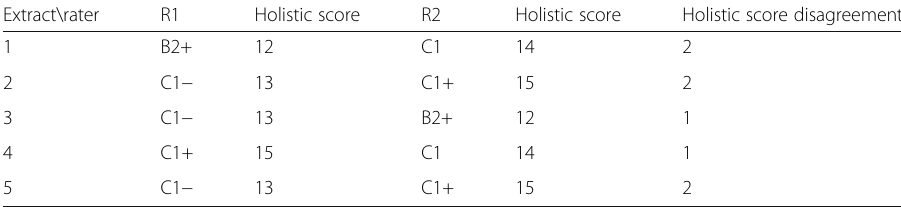
Table 5 Examples of rating results with converted numerical points by raters 1 and 2 Extract\rater